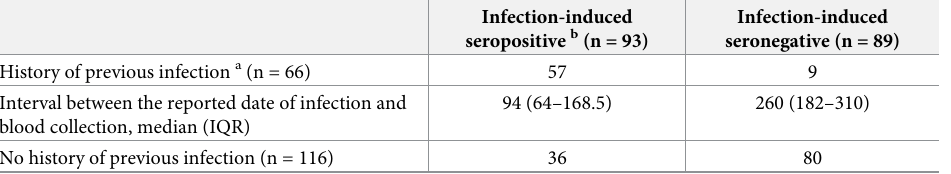
Table 2. Association between infection-induced seropositivity and previous SARS-CoV-2 infection. Number of children who complete a survey of infection history (n = 182) and infection-induced seropositivity during the omi- cron-dominant wave (January–December 2022).